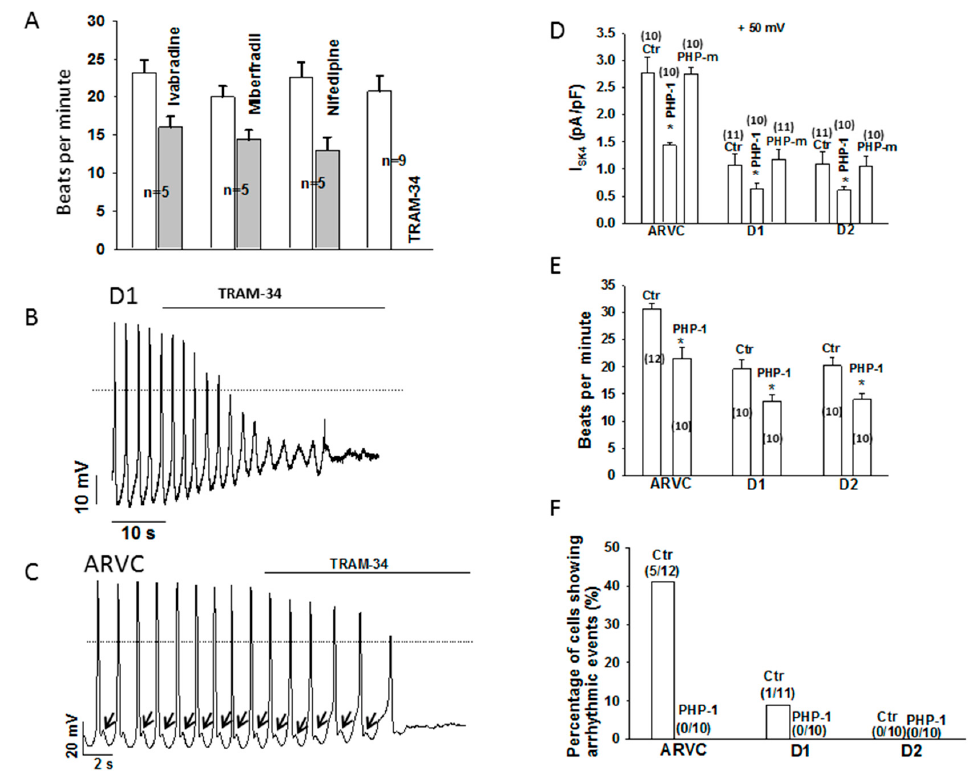
Figure 6. The SK4 channel blocker TRAM-34 and PHP-1 suppressed the cell beating and the occurrence rate of arrhythmic events. A channel specific blocker was applied to cells through a perfusion pipette. The recombinant PHP-1 (100 ng / ml) or the enzyme inactive mutant form of PHP-1 (PHP-m, 100 ng / mL) was applied into cells through the patch pipette. The spontaneous action potentials (sAPs) and I SK4 were recorded before and after the application of the drug. ( A ) Mean values of beating frequency of healthy donor (D1) cells in the absence and presence of 3 µ M ivabradine (blocker of the funny channel), 10 µ M mibefradil (T-type calcium channel blocker), 10 µ M nifedipine (L-type calcium channel blocker) or 1 µ M TRAM-34. ( B ) An example of sAPs in a D1-hiPSC-CM showing that TRAM-34 suppressed cell beating. ( C ) An example of sAPs in an ARVC-hiPSC-CM showing that TRAM-34 suppressed both the cell beating and the delayed afterdepolarizations (black arrows). ( D ) Mean values of I SK4 in donor and ARVC-cells showing that PHP-1 but not its inactive mutant decreased I SK4 . ( E ) Mean values of beating frequency in donor and ARVC-cells showing that PHP-1 reduced the frequency (pacemaker activity) of cells. ( F ) Mean values of the occurrence rate of arrhythmic events in donor and ARVC-cells showing that PHP-1 prevented arrhythmic events. The numbers given represent cell numbers, * p < 0.05.